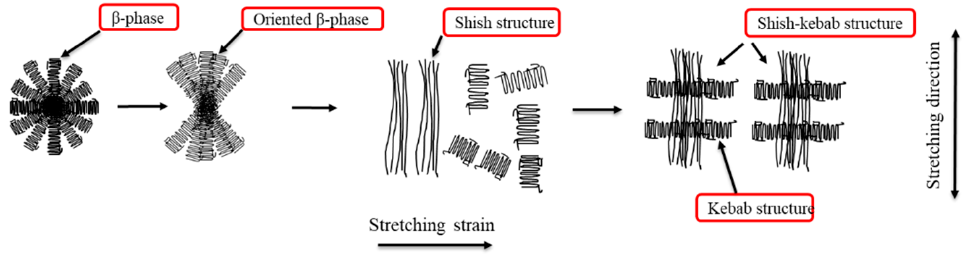
Figure 10. A schematic diagram reflecting the transformation of β -modifications for the stretched iPP sheet.